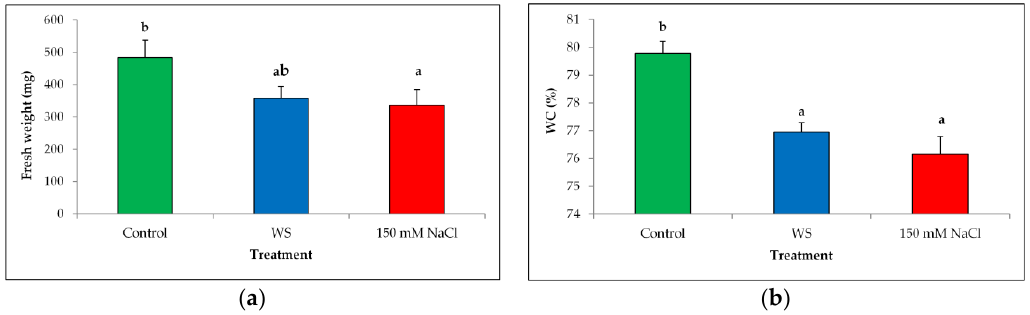
Figure 3. Stress-induced inhibition of growth. Needle fresh weight (FW) ( a ) and water content as a percentage of FW (WC %) ( b ), in Larix decidua after 30 days of water deficit (WS) and salt (150 mM NaCl) stress treatments. Bars represent means with SE ( n = 7). Different letters above the bars indicate significant differences between treatments, according to Tukey’s test ( α = 0.05).